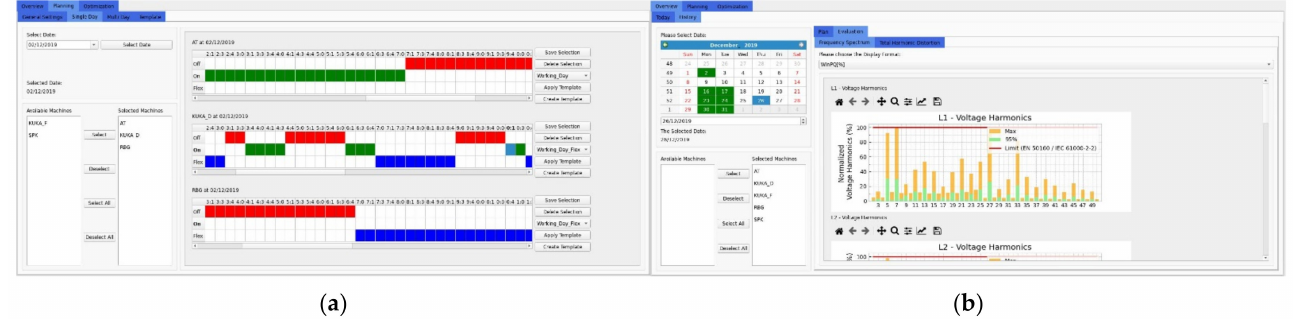
Figure 13. ( a ) Human Machine Interface for the intelligent process planning scheme with flexibility declaration. ( b ) Interface of the results for the simulated grid state including the designated, controlled machine